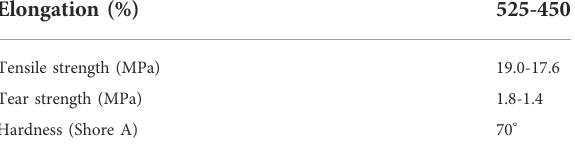
TABLE 2 Physical properties of nitrile